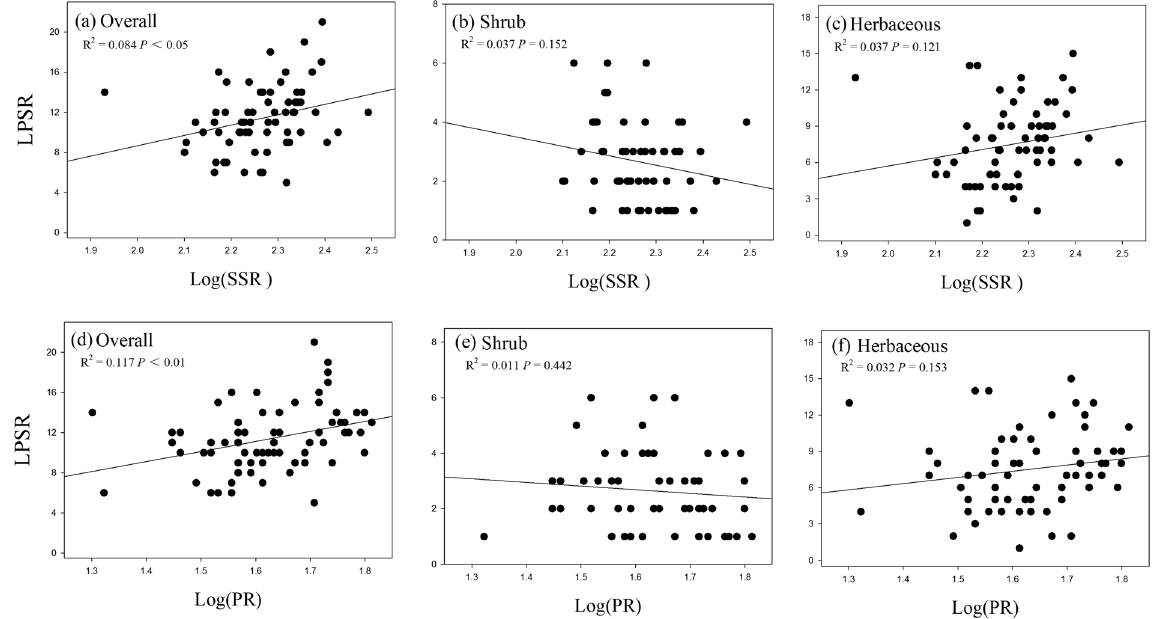
Figure 5. Relationships between overall, shrub, and herbaceous LPSR and soil saprotrophic ( a – c ) and pathogenic richness ( d – f ). Log(SSR), Log(saprotrophic richness); Log(PR), Log(pathogenic